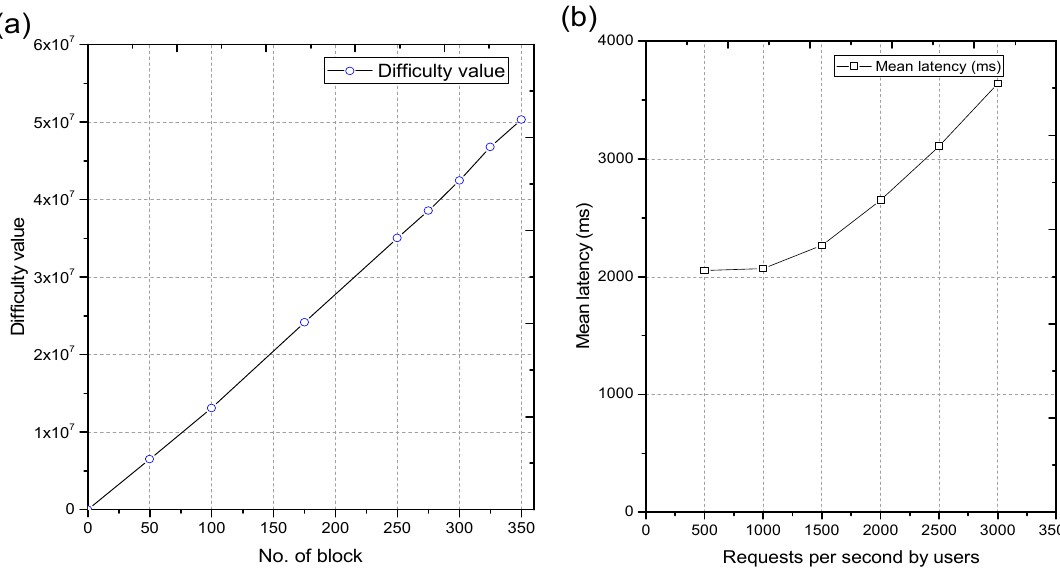
Figure 7. ( a ) Difficulty variation vs number of blocks, and ( b ) mean latency vs. number of user’s requests.